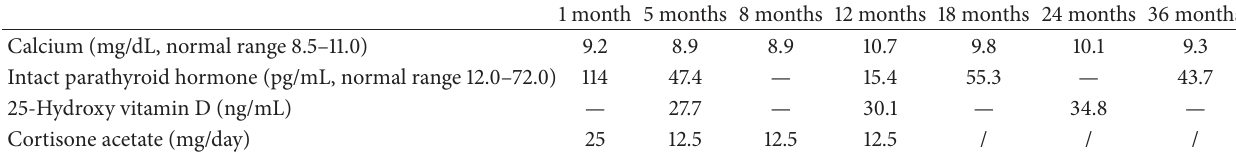
Table 1: Calcium, PTH, and 25-OH vitamin D levels and cortisone acetate daily therapy throughout three years after intervention.